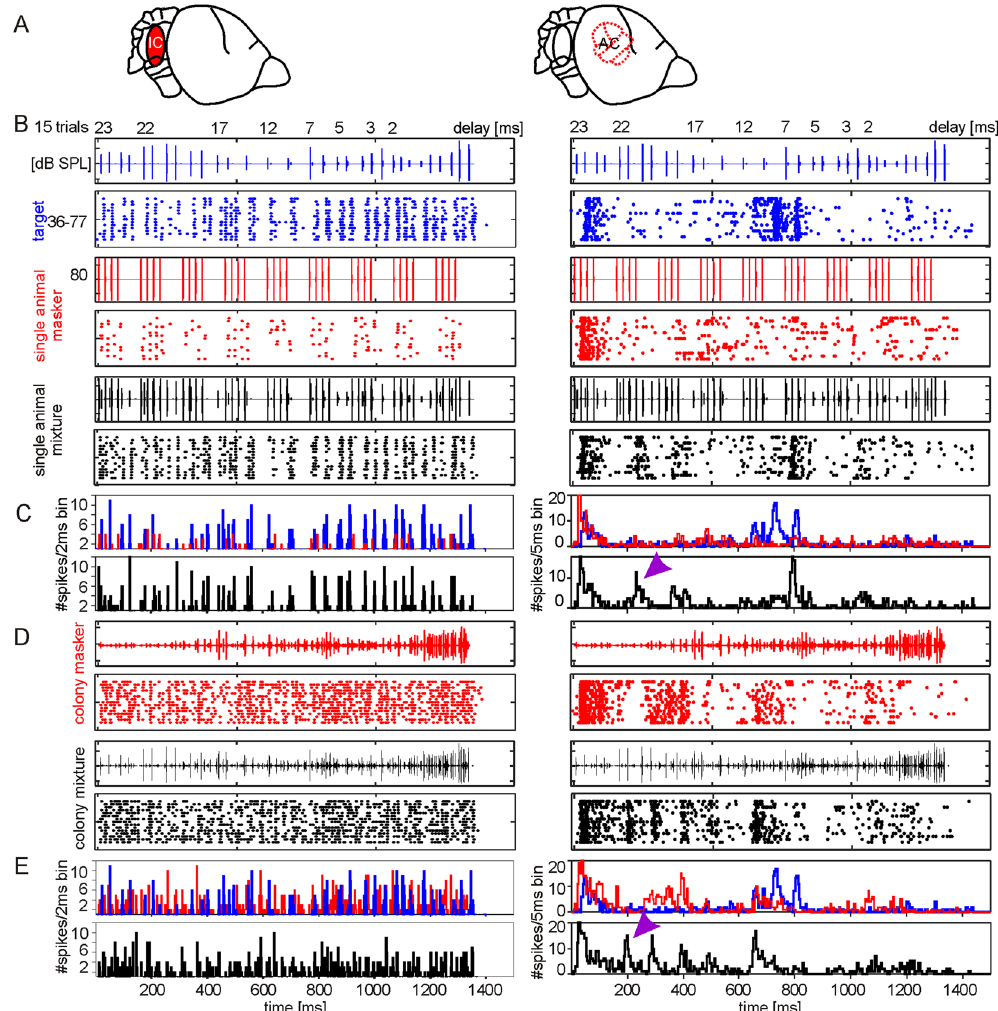
Figure 2. Neuronal responses of a collicular (left column) and a cortical (right column) unit. ( A ) Schematic lateral view on C. perspicillata ’s brain. Recorded brain areas are highlighted (inferior colliculus (IC); auditory cortex (AC)). Raster plots ( B , D ) and PSTHs ( C , E ; binsize = 2 ms for collicular and 5 ms for cortical unit) show the neuronal activity of a representative collicular and cortical unit in response to the target (blue raster plot in A, blue PSTHs in B and C ), to the single animal masker (red raster plot in B , red PSTH in C ), to the colony masker (red raster plot in D, red PSTH in E), to the single animal mixture (black raster plot in B, black PSTH in C ), and to the colony mixture (black raster plot in D , black PSTH in E ). Oscillograms of the stimuli are indicated above each raster plot. Violet arrowheads point to neuronal responses elicited by a stimulus interference of the target and